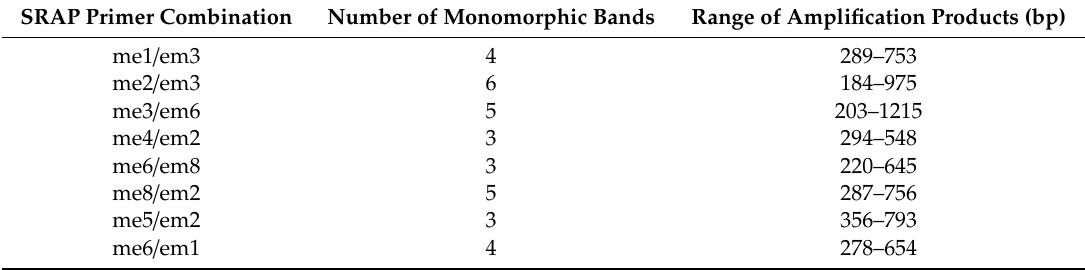
Table 3. Amplification products resulted with sequence-related amplified polymorphism (SRAP) primers of Rheum rhabarbarum